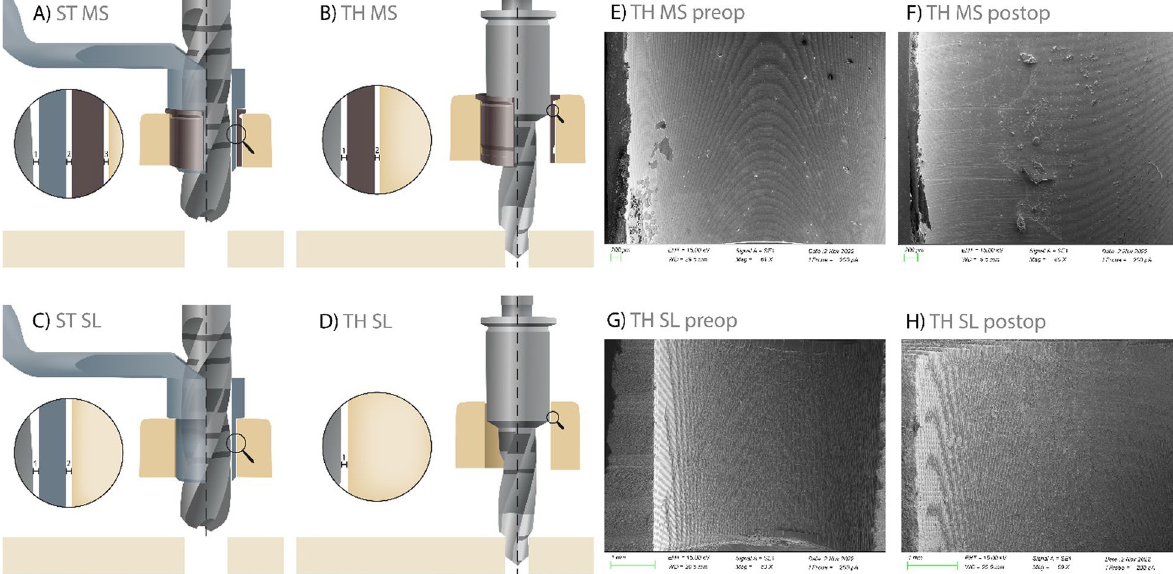
Fig. 2 Guide‑hole designs: manufacturer sleeve sites for the drill‑key system ( A ) including three gaps between drill, key, sleeve, and guide material; and the keyless system ( B ) including two gaps between drill, sleeve, and guide material. Sleeveless sites for the drill‑key system ( C ) including two gaps between drill, key, and guide material; and the keyless system ( D ) including one gap between drill and guide material. Visualization of the keyless TH guide‑hole deterioration via scanning electron microscope images representing pre‑ and post‑operative sites for MS ( E , F ) and SL ( G , H